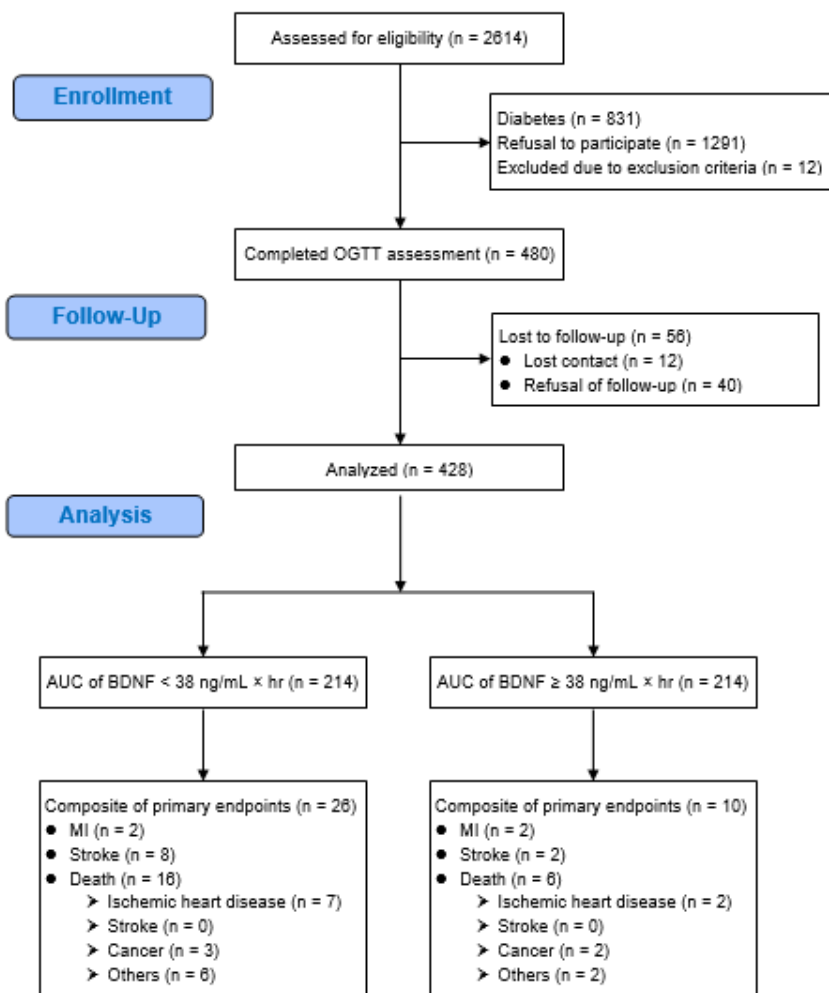
Figure 1. Flow diagram of the enrollment of study patients who had angina. AUC = area under the curve, BDNF = brain-derived neurotrophic factor, MI = myocardial infarction, OGTT = oral glucose tolerance test. Table 1. The characteristics of patients who completed follow-up and those who were lost to follow-up.